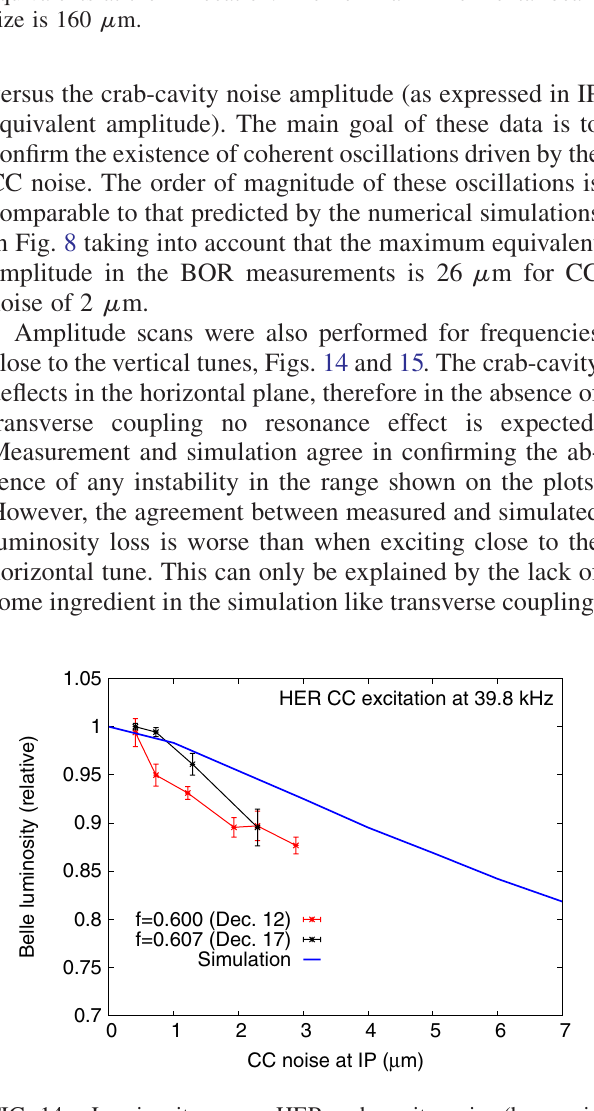
FIG. 14. Luminosity versus HER crab-cavity noise (harmonic excitation) as extrapolated to IP displacement. The excitation frequency (0.599 in tune units) is close to the HER vertical tune. The nominal IP horizontal beam size is 180 (cid:3) m .